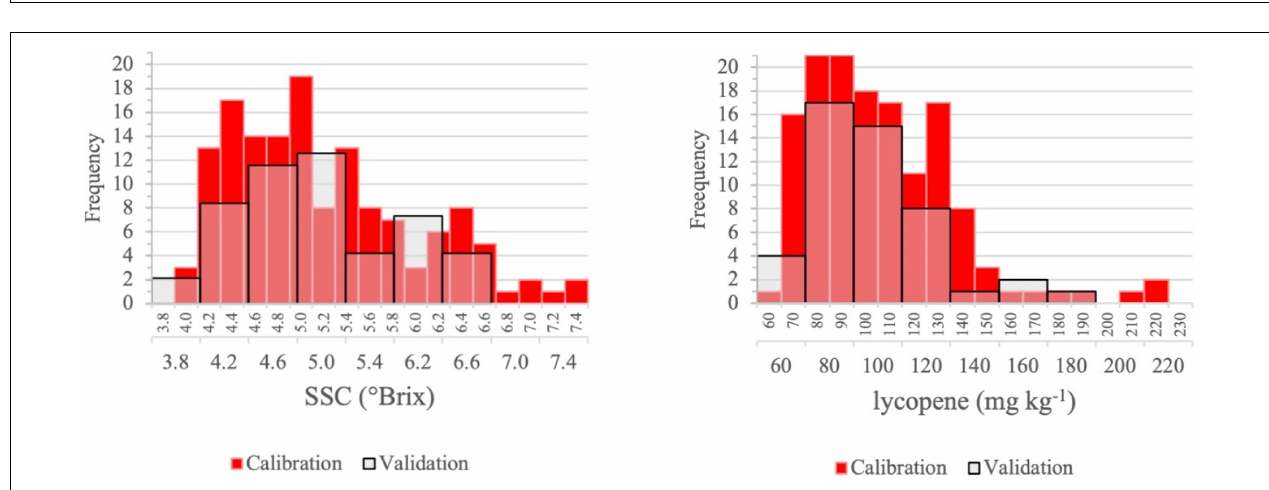
FIGURE 4 | Distribution of SSC and lycopene content of intact tomato fruit for the calibration ( n = 99) and validation ( n = 33) sets.